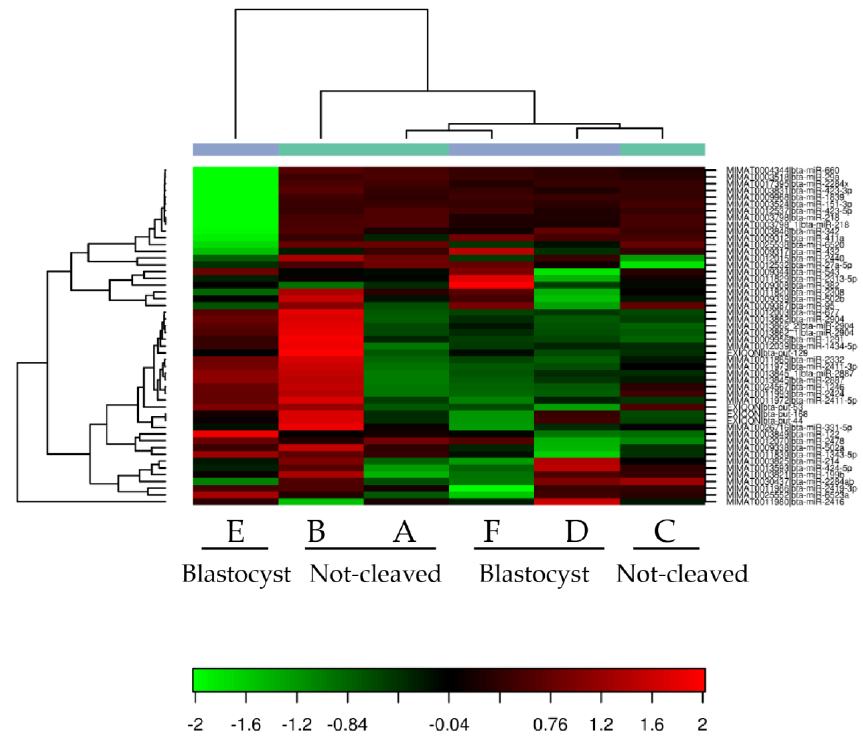
Figure 3. Heat map of the tested cumulus cell samples. Heat map and unsupervised hierarchical clustering by sample and miRNA. The clustering was performed on all samples and on the top 50 miRNAs with the highest % CV based on TPM (transcripts per million) normalized reads. A, B, C = cumulus pieces surrounding oocytes that failed to cleave after exposure to sperm; D, E, F = cumulus pieces surrounding oocytes that developed into blastocysts after fertilization.